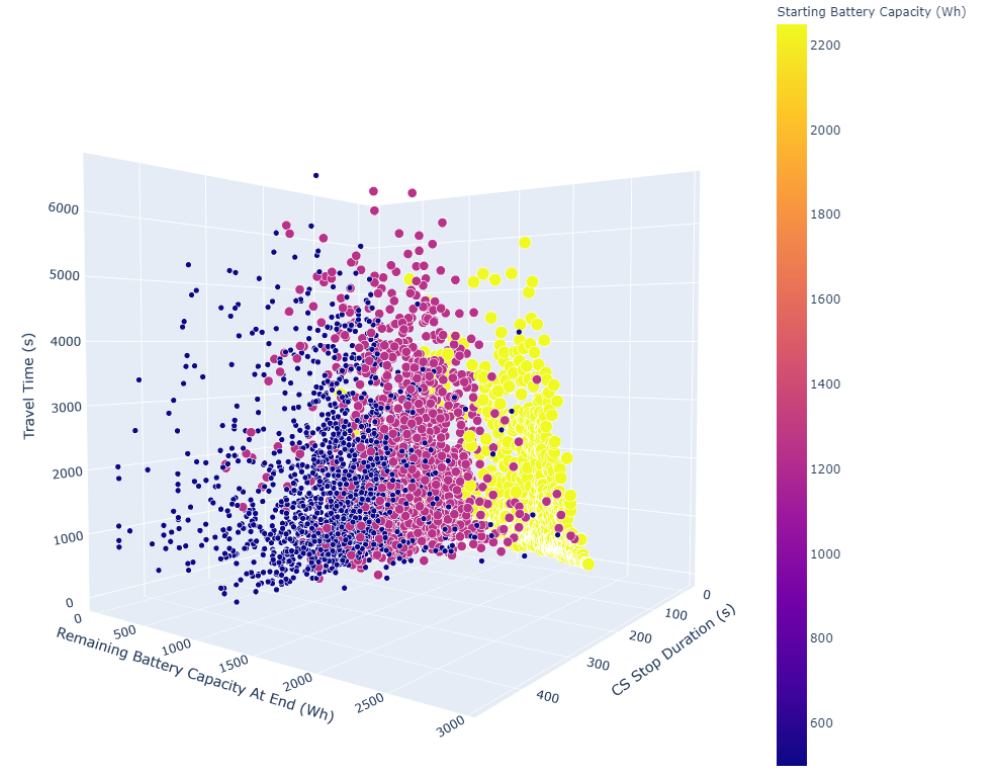
Figure 9. The achieved travel time under varying starting battery capacities and CS stop durations: the case of the Manchester road